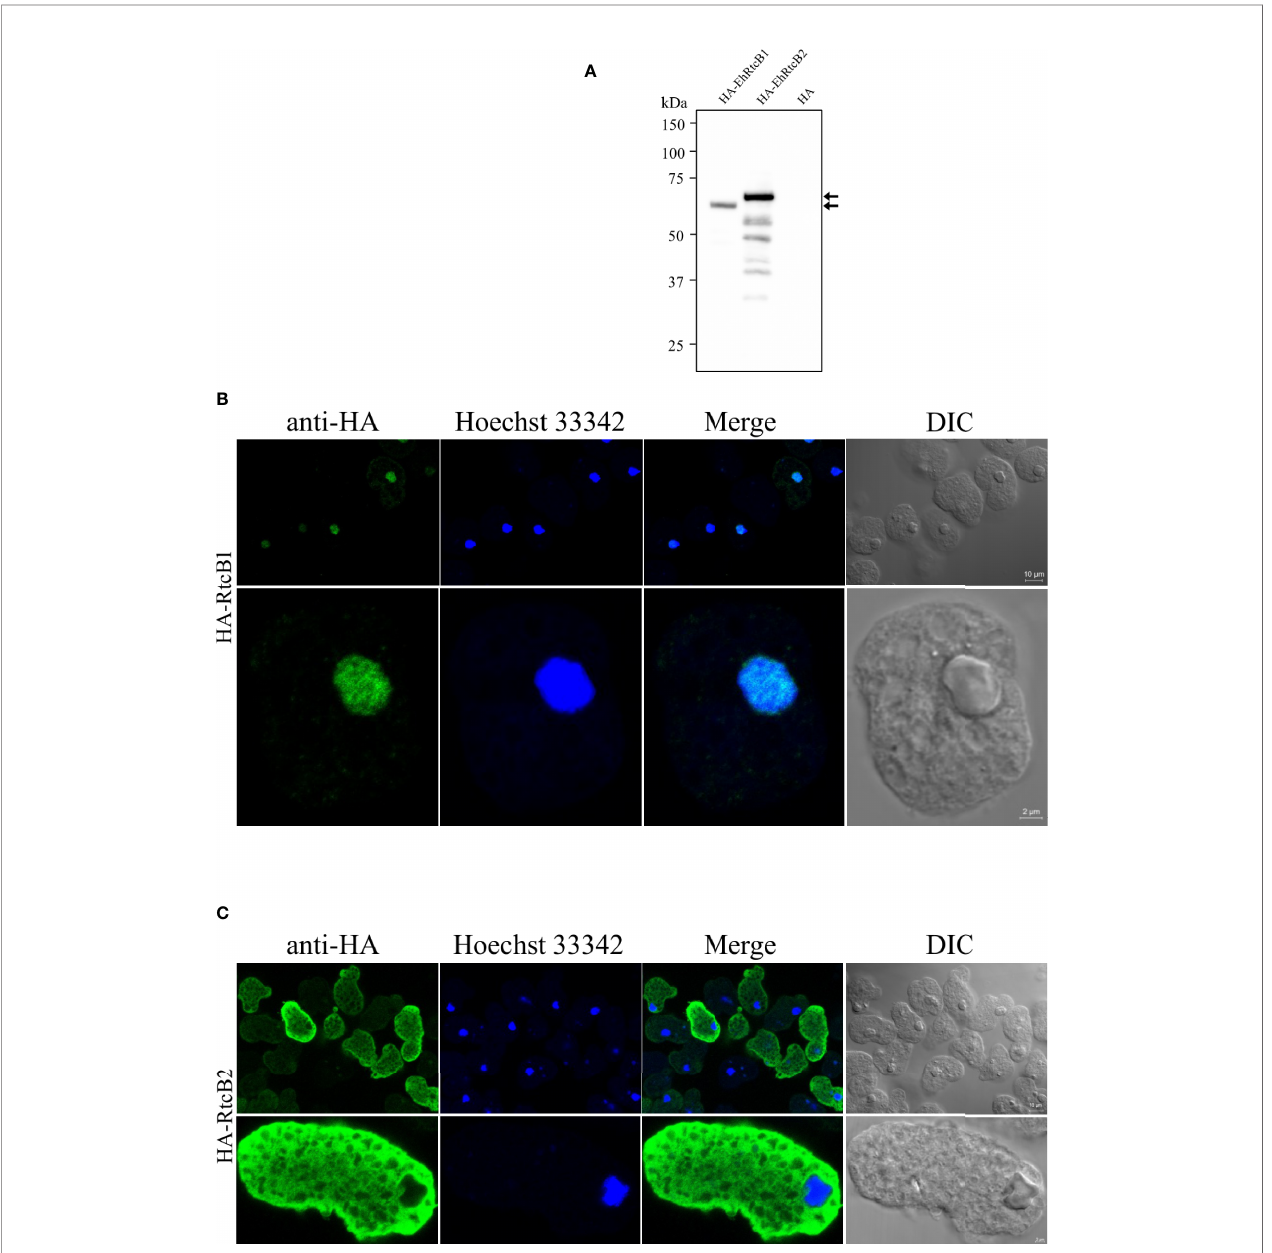
FIGURE 5 | Expression and cellular localization of HA-tagged EhRtcB1 and EhRtcB2. (A) Expression of HA-RtcB1 and HA-RtcB2 veri fi ed by SDS-PAGE and immunoblot analysis. Cell lysates from the transformant strains that expressed HA-RtcB1 (61.3 kDa) or HA-RtcB2 (62.9 kDa) were subjected to SDS-PAGE and immunoblot analysis using anti-HA antibody. Arrows indicate the untruncated HA-EhRtcB1 and HA-EhRtcB2. (B, C) Microscopic images of the amebic trophozoites expressing HA-EhRtcB1 (B) and HA-EhRtcB 2 (C) . Images of trophozoites that were fi xed, permeabilized, reacted with anti-HA primary antibodies, anti-mouse and anti-rabbit IgG secondary antibodies, and stained with Hoechst were captured on a LSM 780 confocal microscope. Images are shown with a low (upper panels) and high magni fi cation (lower panels). HA, Hoechst, merged, and differential interference contrast (DIC) images are